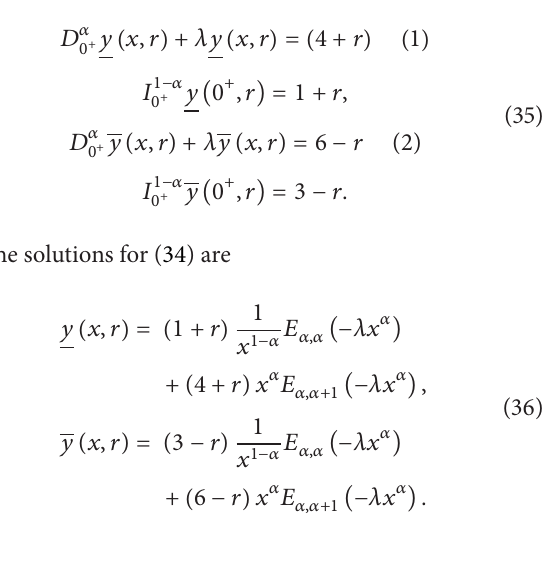
Figure 17: 𝛼 = 0.3 and 𝜆 = 2 .